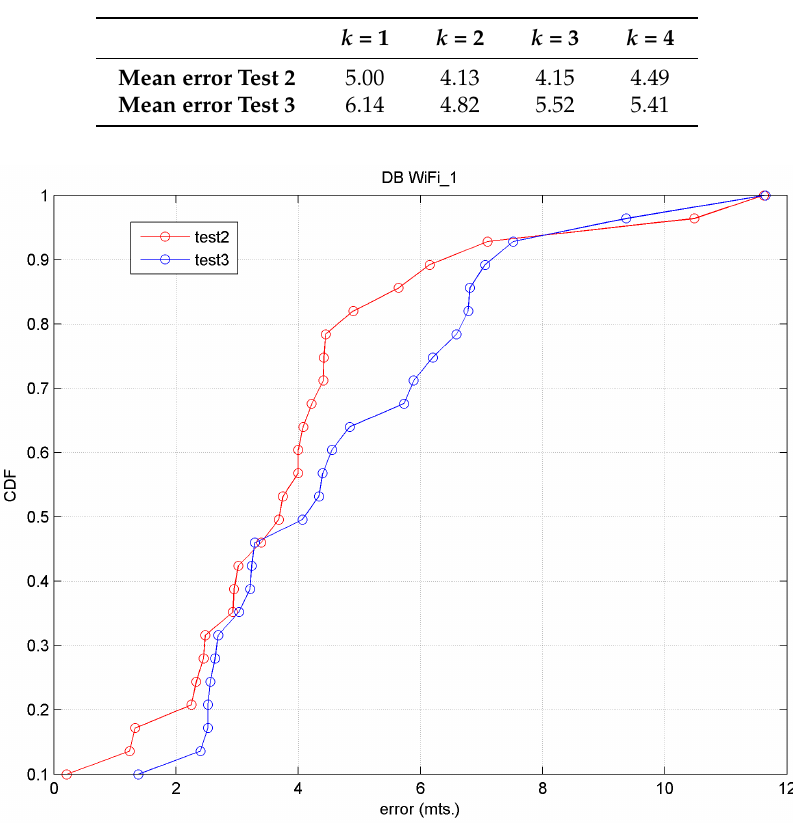
Table 4. Comparison of the accuracy of Test 2 and Test 3 for the Wi-Fi_1 database: mean errors for different k -values.